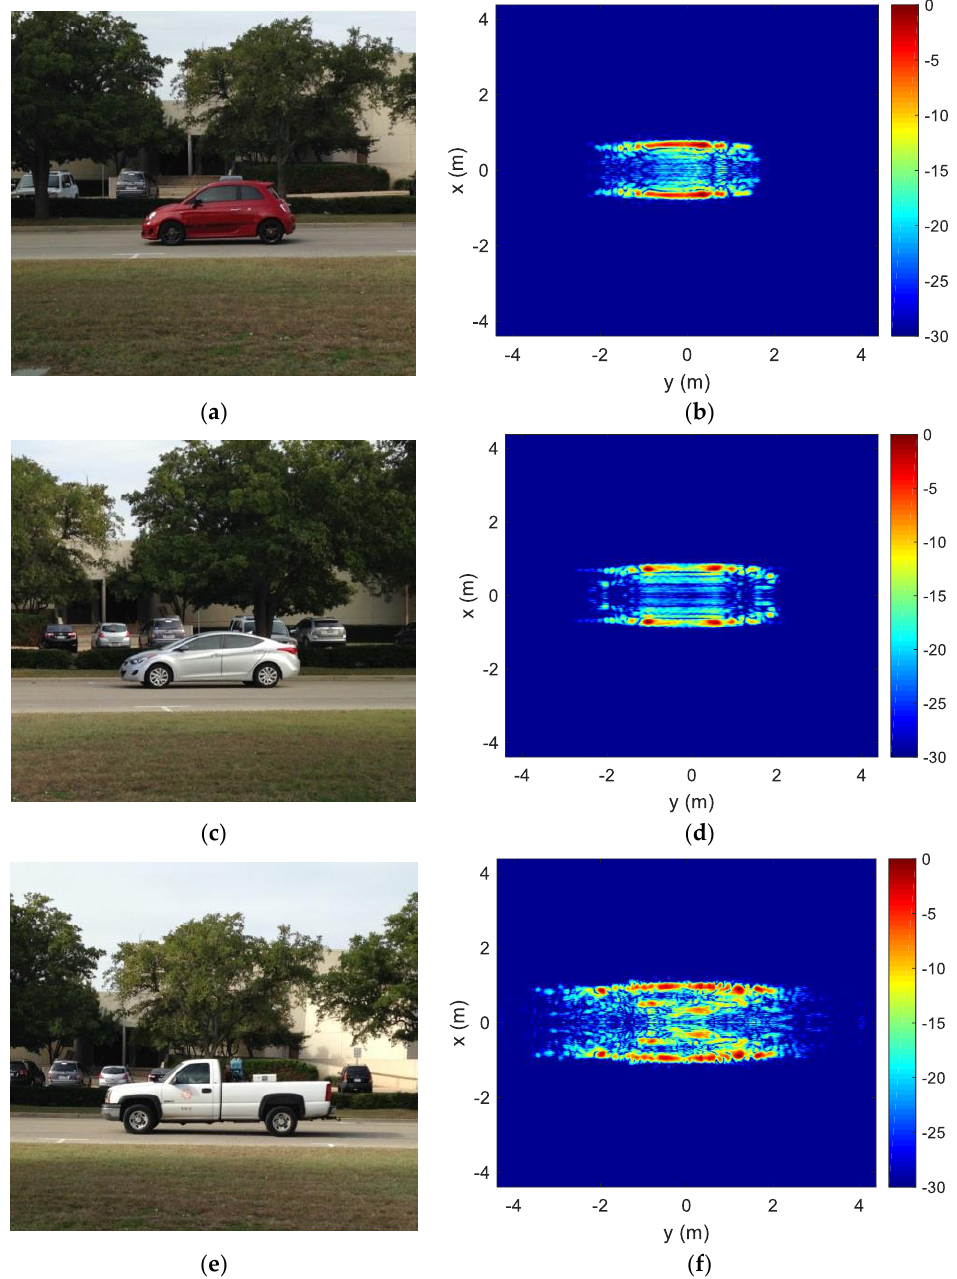
Figure 4. Wide-angle ISAR imaging of different vehicles. ( a ) Subcompact photo; ( b ) Subcompact ISAR image; ( c ) Mid-size sedan photo; ( d ) Mid-size sedan ISAR image; ( e ) Large truck photo; ( f ) Large truck ISAR image.